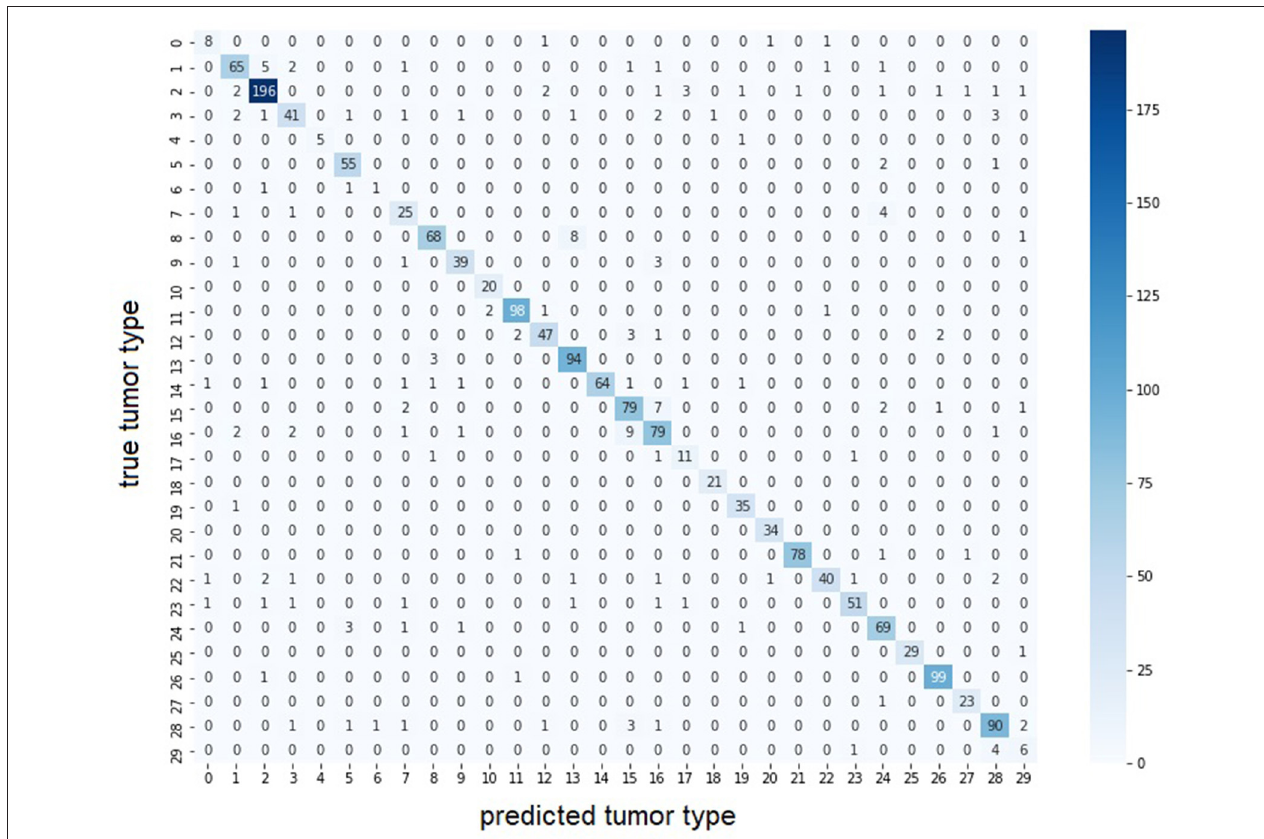
FIGURE 3 | Confusion matrix of multi-scale MIL model trained at 5x and 10x on the entire dataset. The largest values for each row are found on the diagonal indicating the predicted tumor type correspond to the true tumor type. Color intensity represents number of samples in the class. With lower color intensity there are less samples and the task becomes harder. Correspondence between class id and tumor name is presented in Supplementary Table 1 .